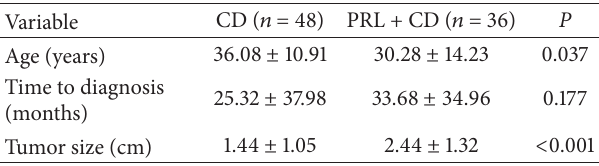
Table 1: Preoperative demographic characteristics and tumor sizes of the patients in the two groups.